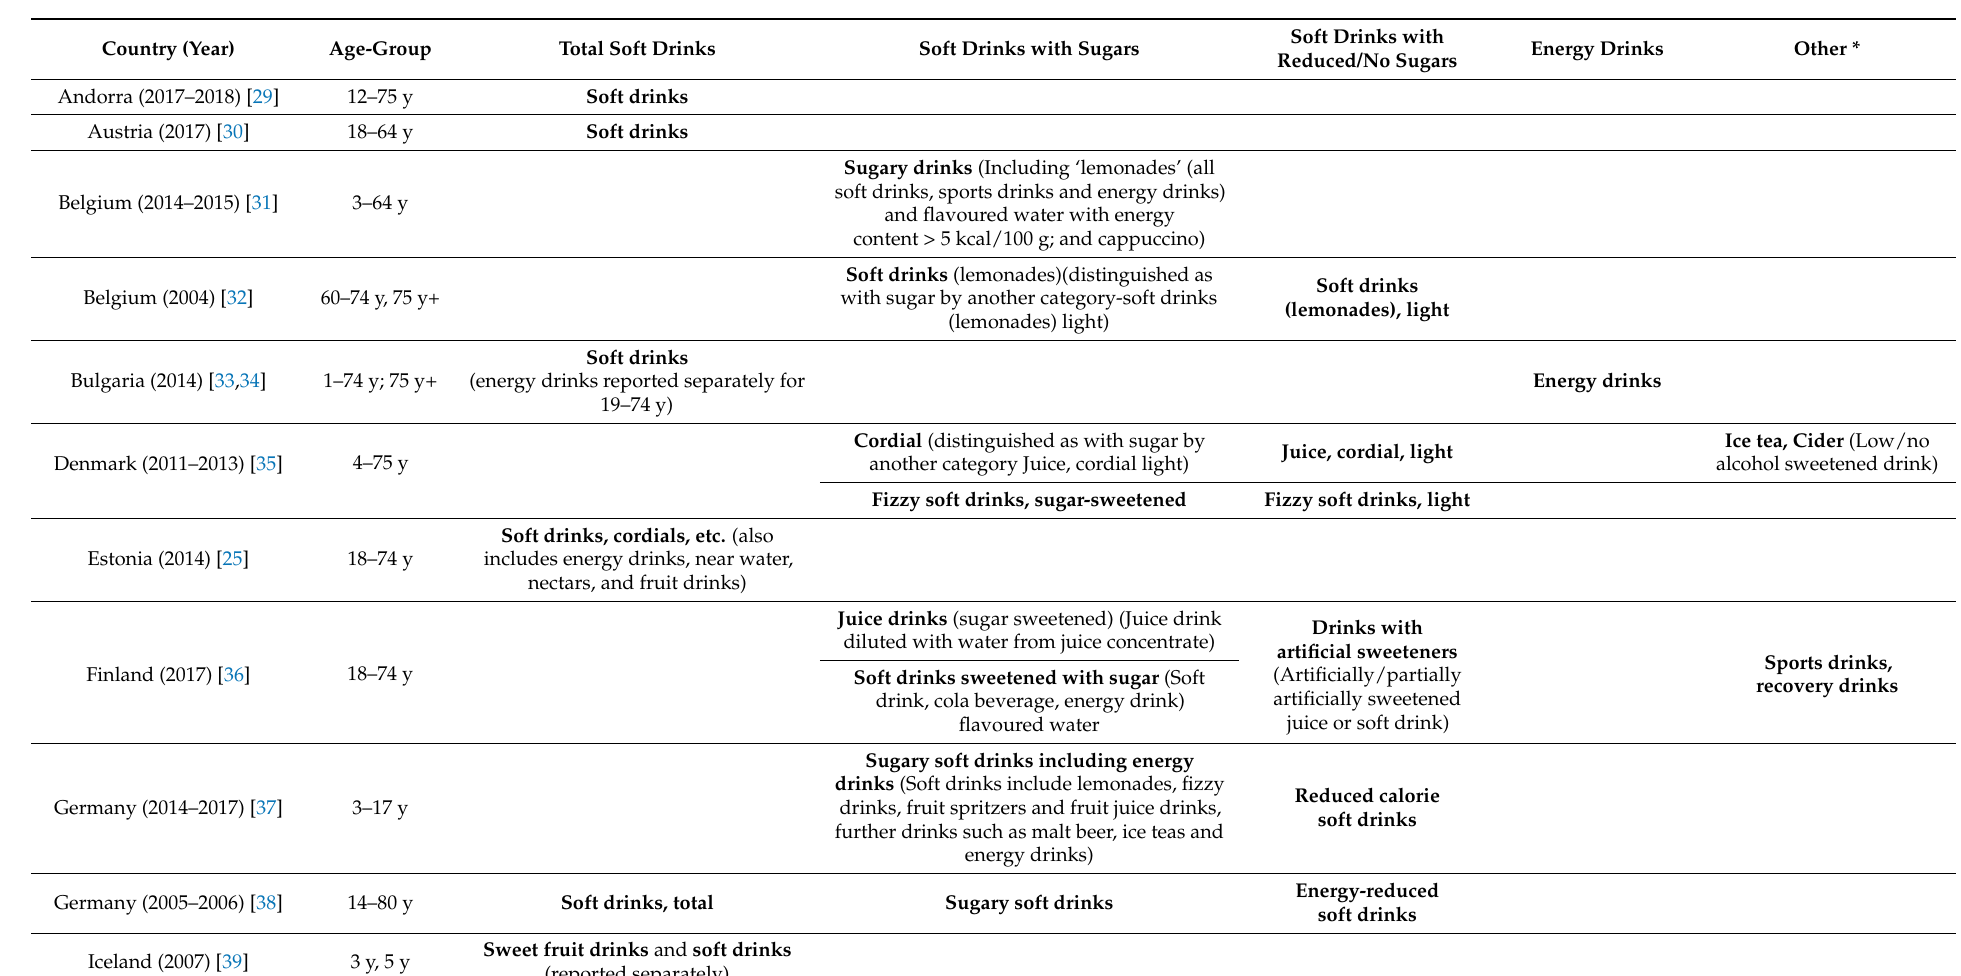
Table 1. Soft drink categories derived from the categories reported in National Food Consumption Surveys in the WHO European